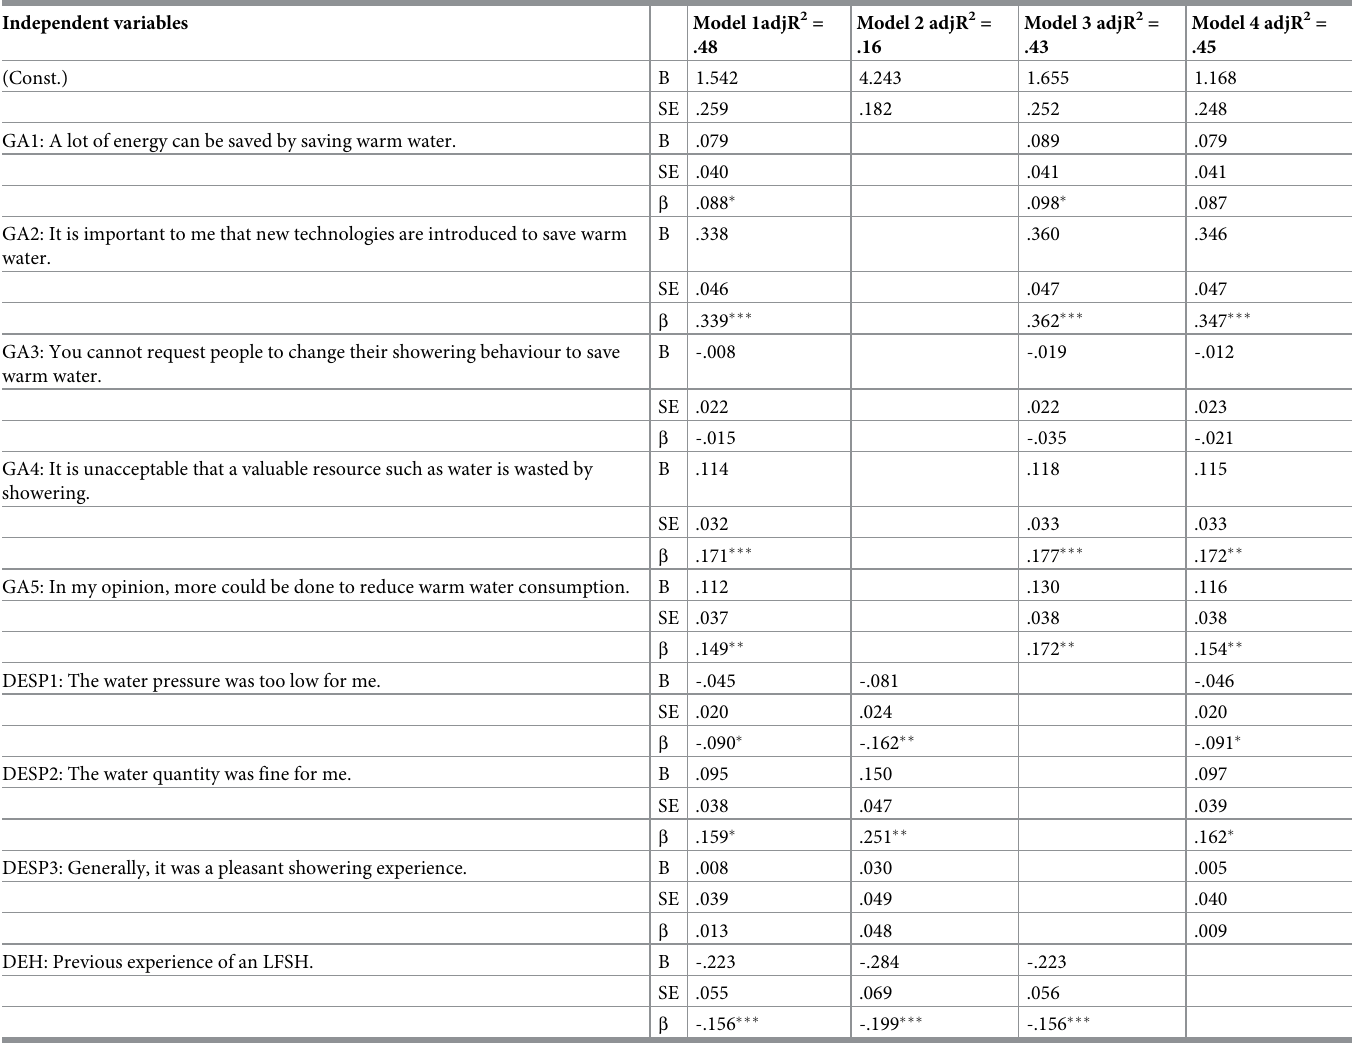
Table 4. Regression analysis to explain attitudes towards LFSHs. Independent